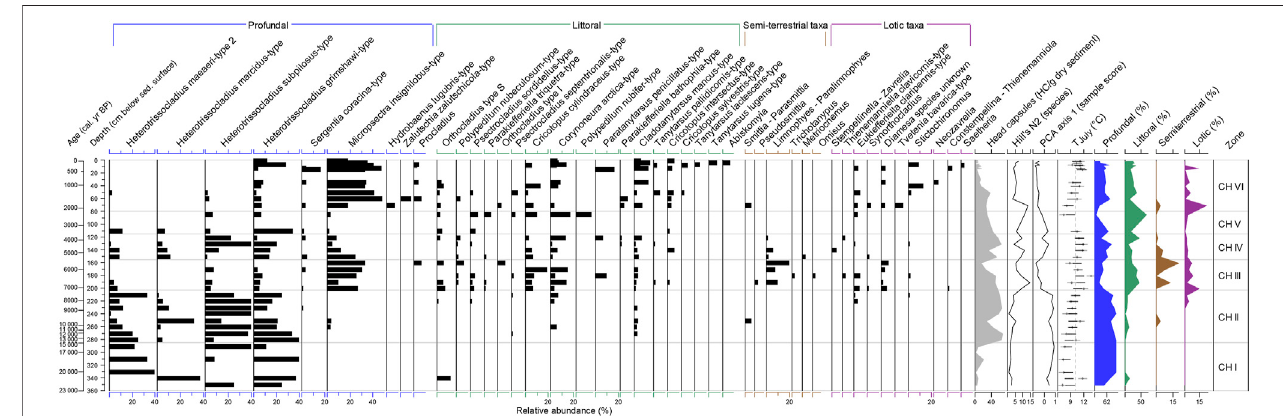
FIGURE 7 | Relative proportions of the most abundant chironomid taxa (%), concentration of chironomid head capsules (HC), PCA axes 1 scores for chironomid data, chironomid-inferred mean July air temperature (T July ), Hill ’ s N2 diversity and relative abundances (%) of littoral, profundal, lotic and semiterrestrial taxa in the sediment core PG2208 of Lake Bolshoe Toko. Grey vertical line at T July represents modern mean July air T ( °